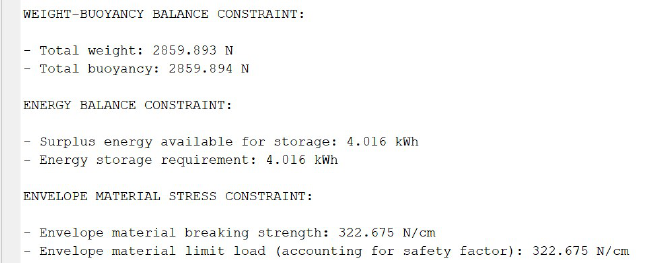
Figure 8. Constraints check for HAPS optimal design for operation at 20 km altitude above Pontianak, Indonesia.